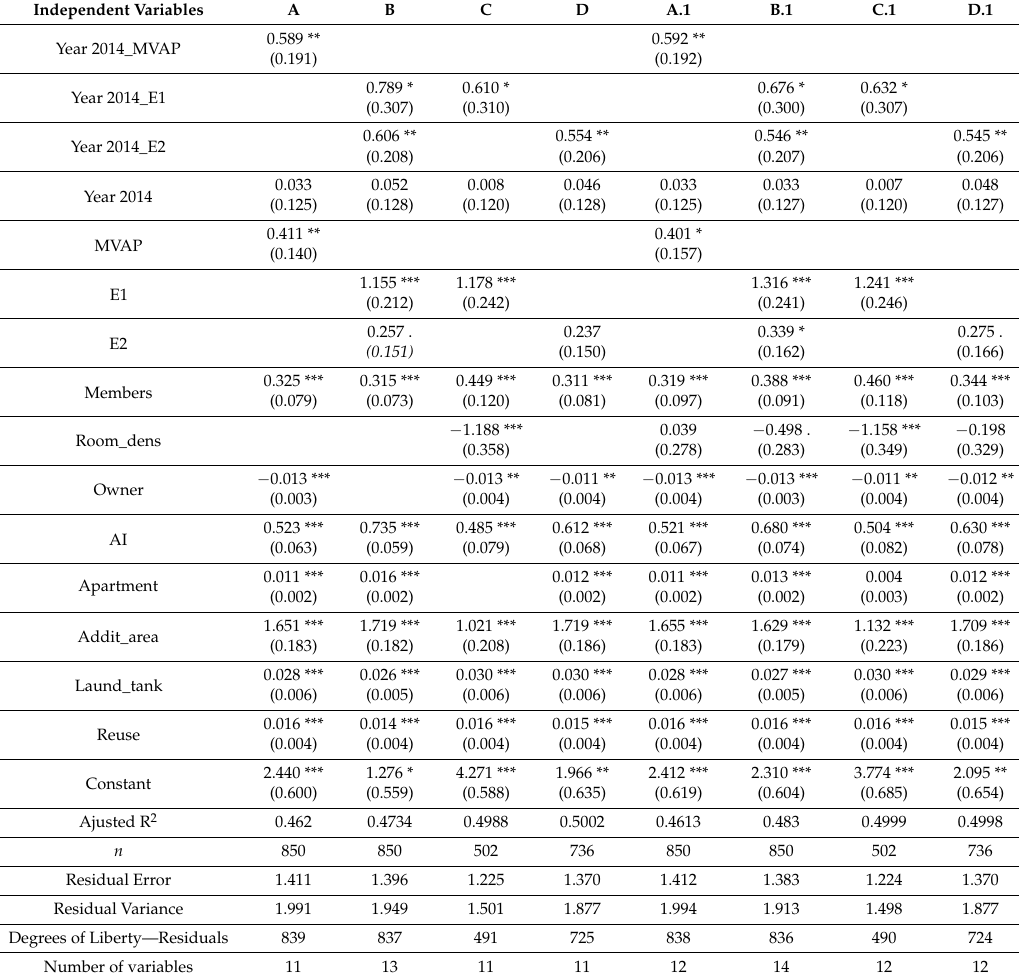
Table 6. Results of the difference-in-difference regression